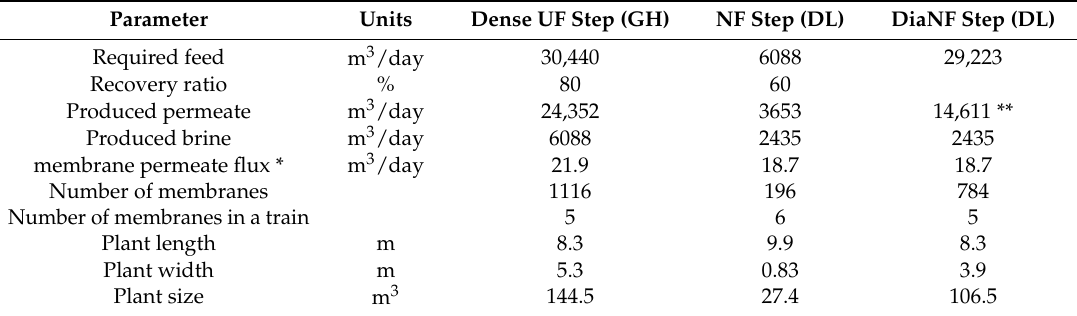
Table 8. Calculated size of the proposed Mg-enrichment membrane